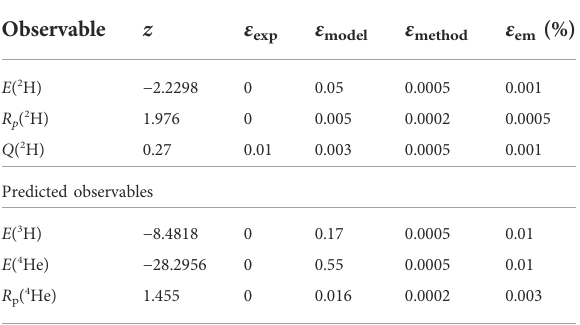
TABLE 1 Target values, z , and error assignments, ε , for observables used in the model calibration and for predictions. Energies in [MeV], point-proton radii in [fm], and the deuteron quadrupole moment in [ e 2 fm 2